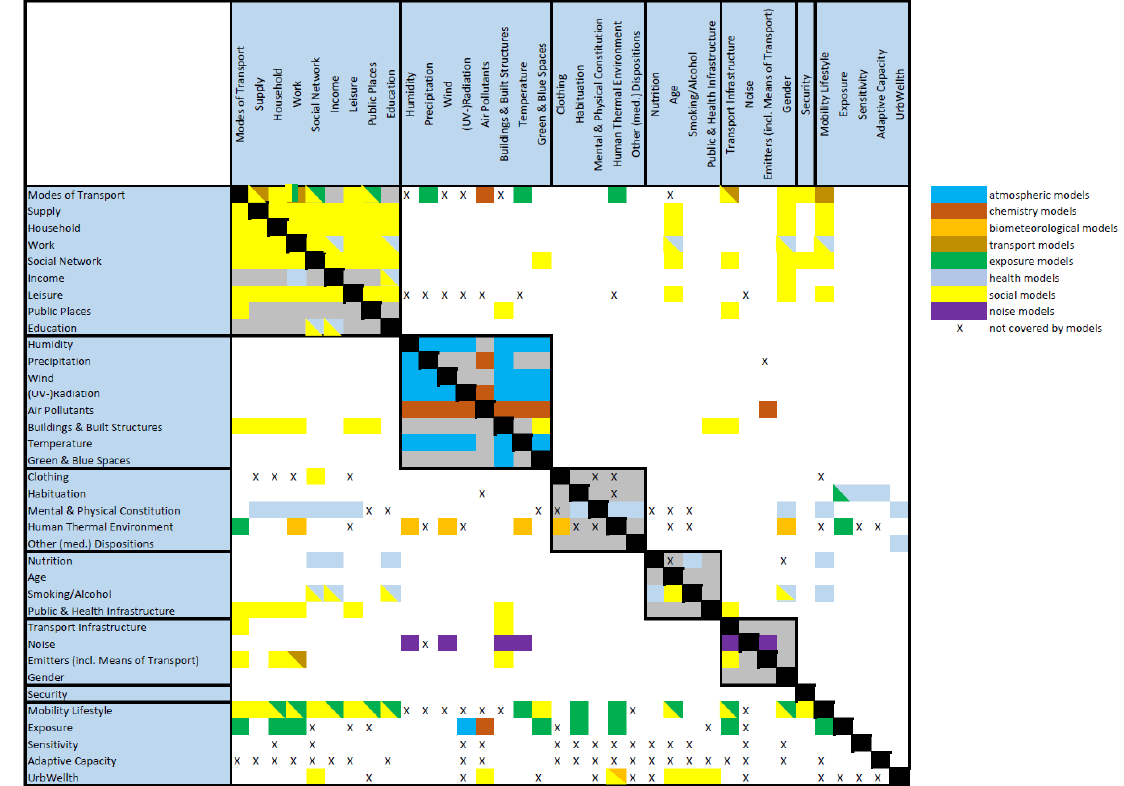
Figure 5. Multi-Domain Design Structure Matrix (MDDSM) of a conceptual model of UrbWellth.